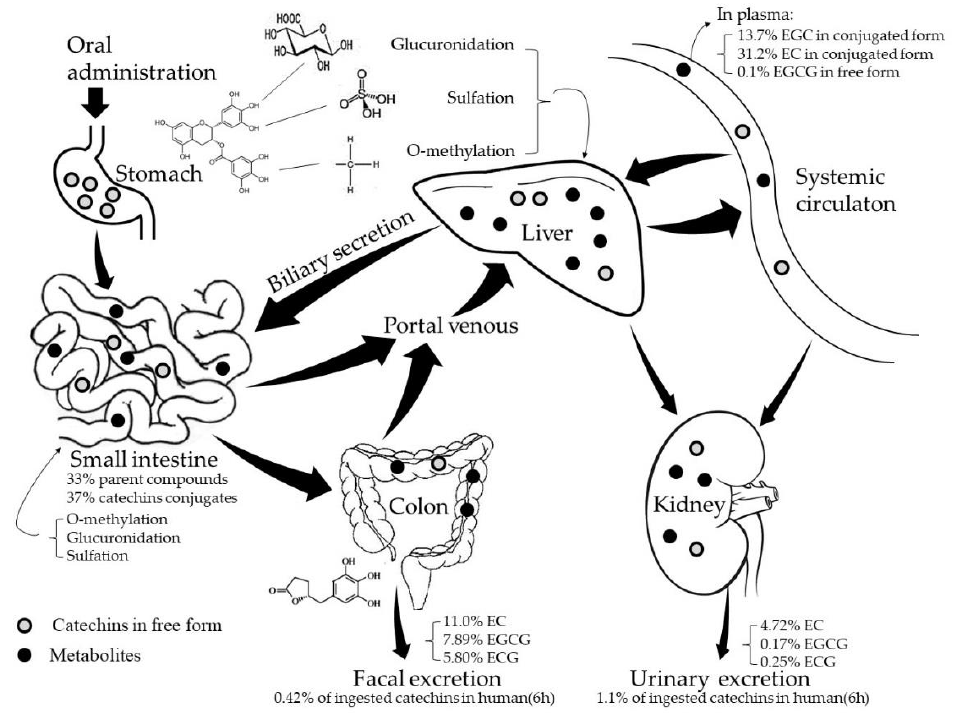
Figure 1. Schematic diagram of metabolism of green tea catechins [ Error! Bookmark not defined. , Error! Bookmark not defined. , Error! Bookmark not defined. ,37].